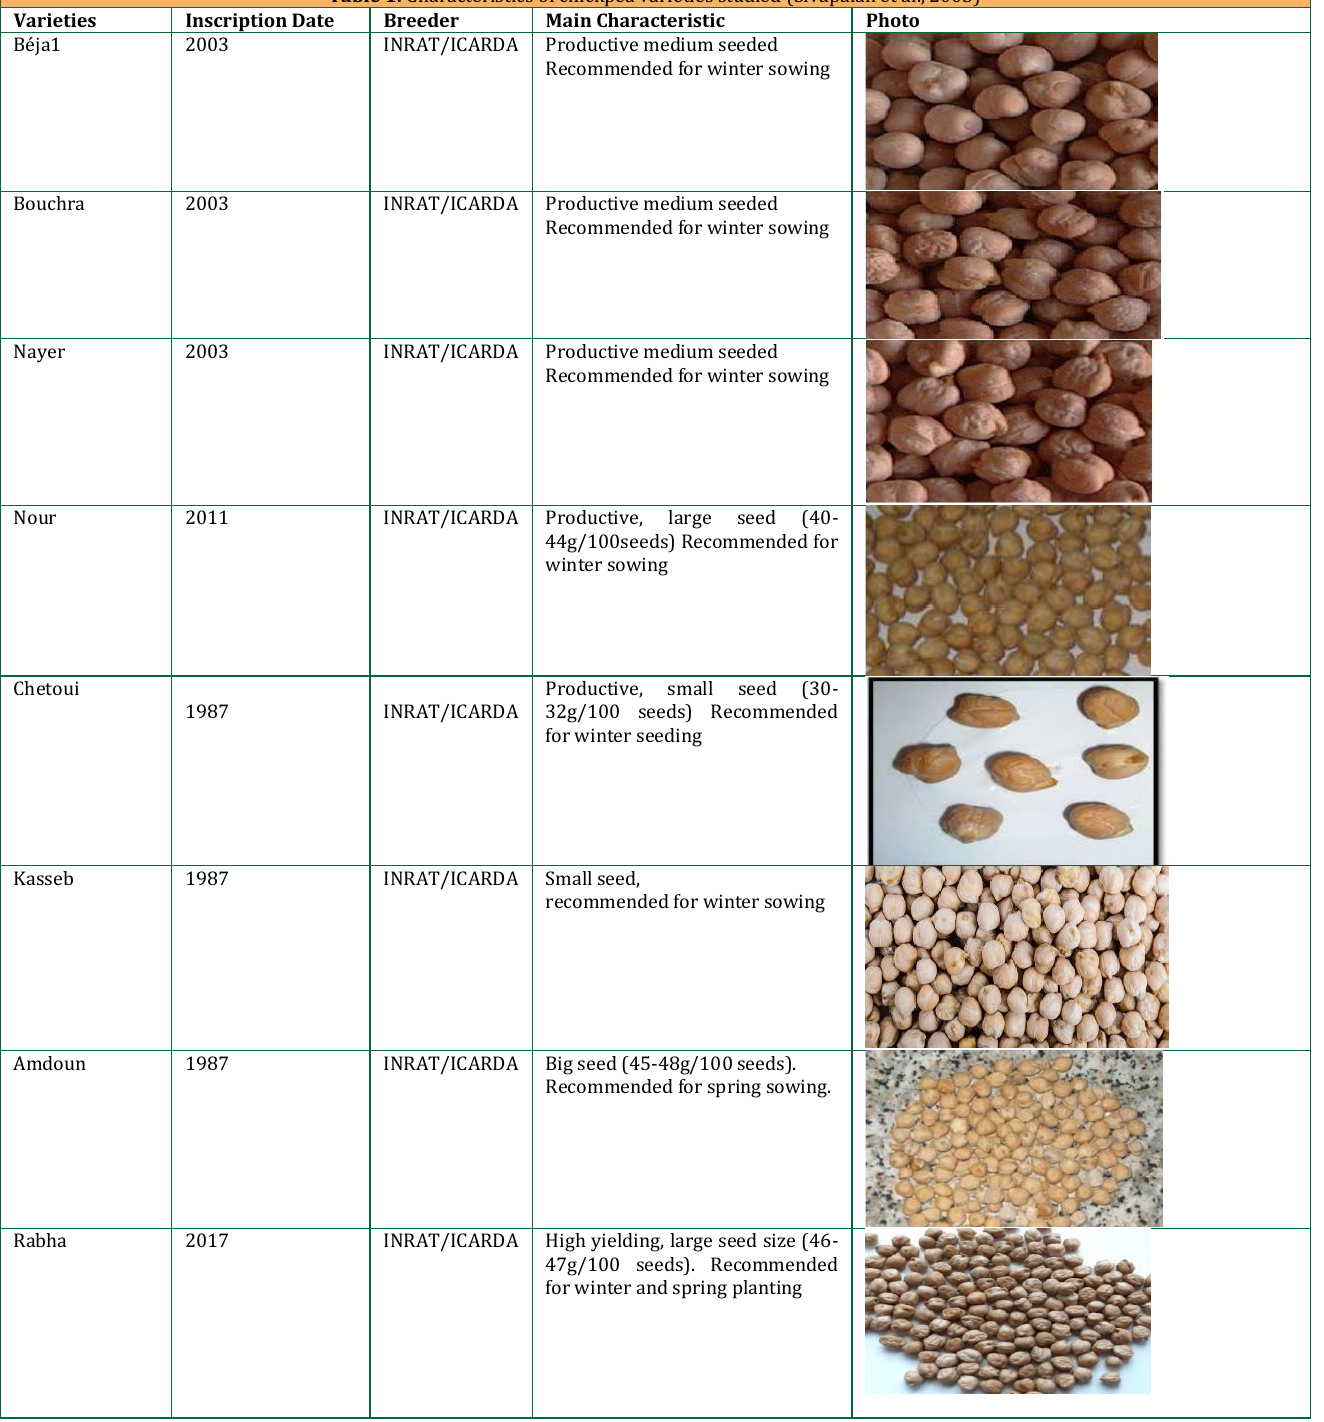
Table 1: Characteristics of chickpea varieties studied (Sivapalan et al., 2003)